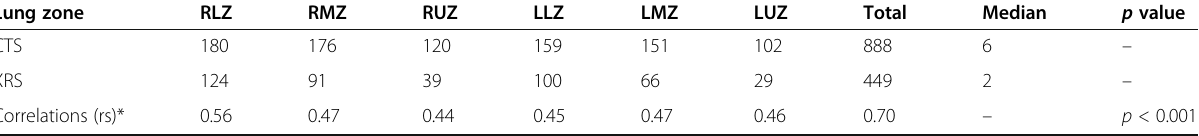
Table 3 Zonal and total CTSs and XRSs; sum of values, medians, correlation coefficients (rs) ( n = 113) Lung zone